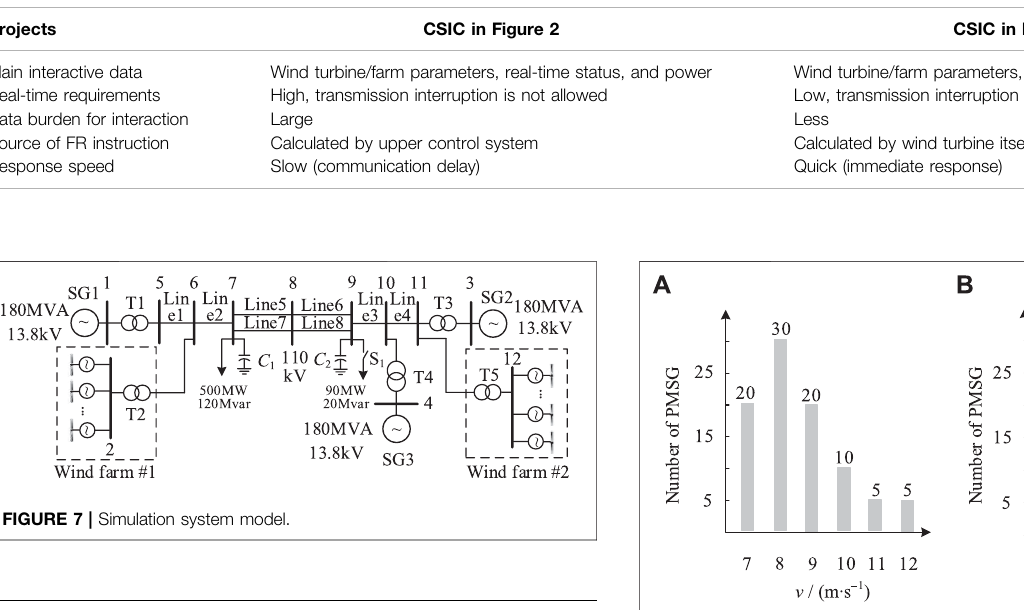
TABLE 2 | Wind farm parameters and wind